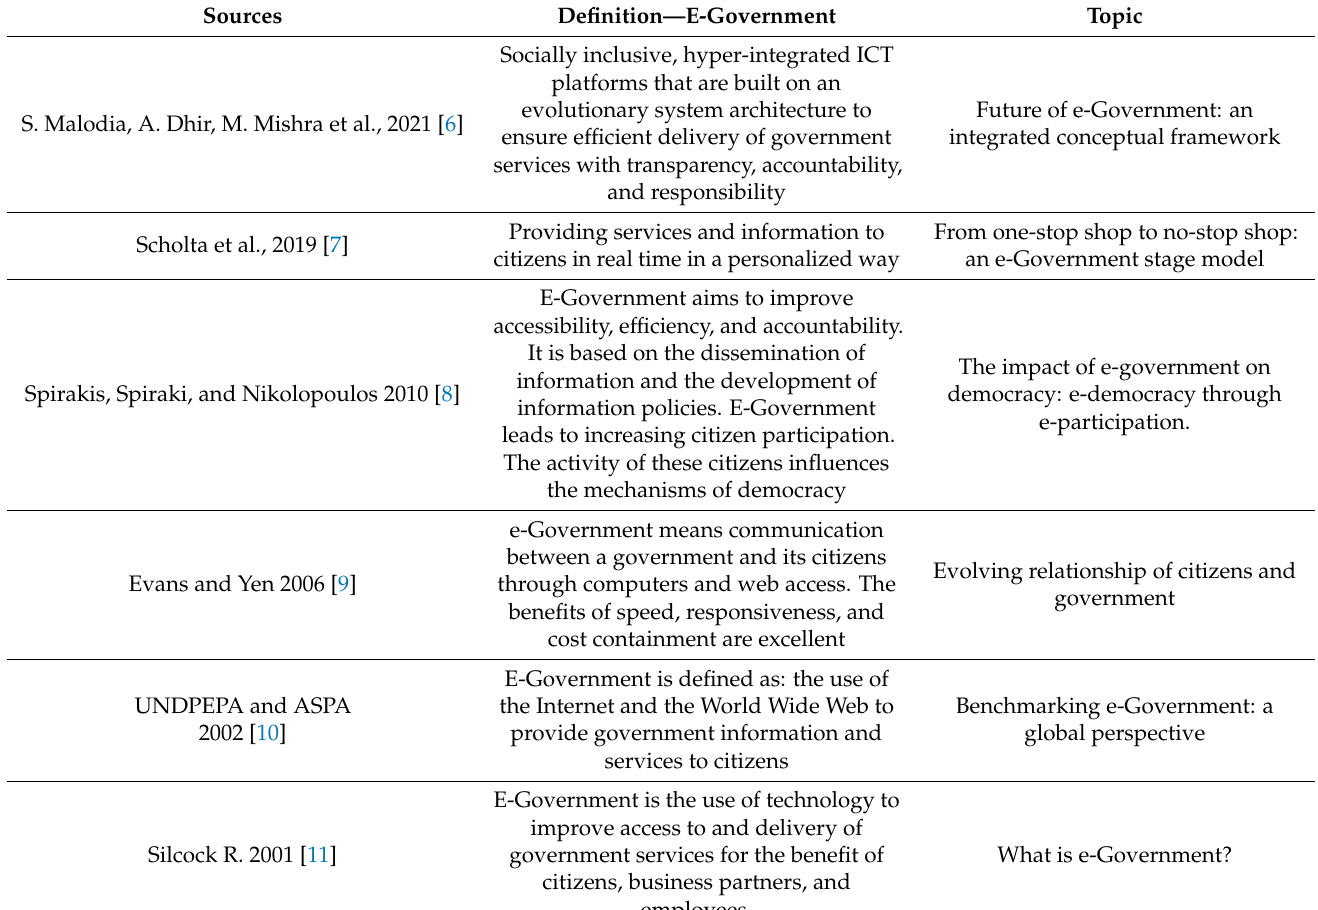
Table 1. Definitions of